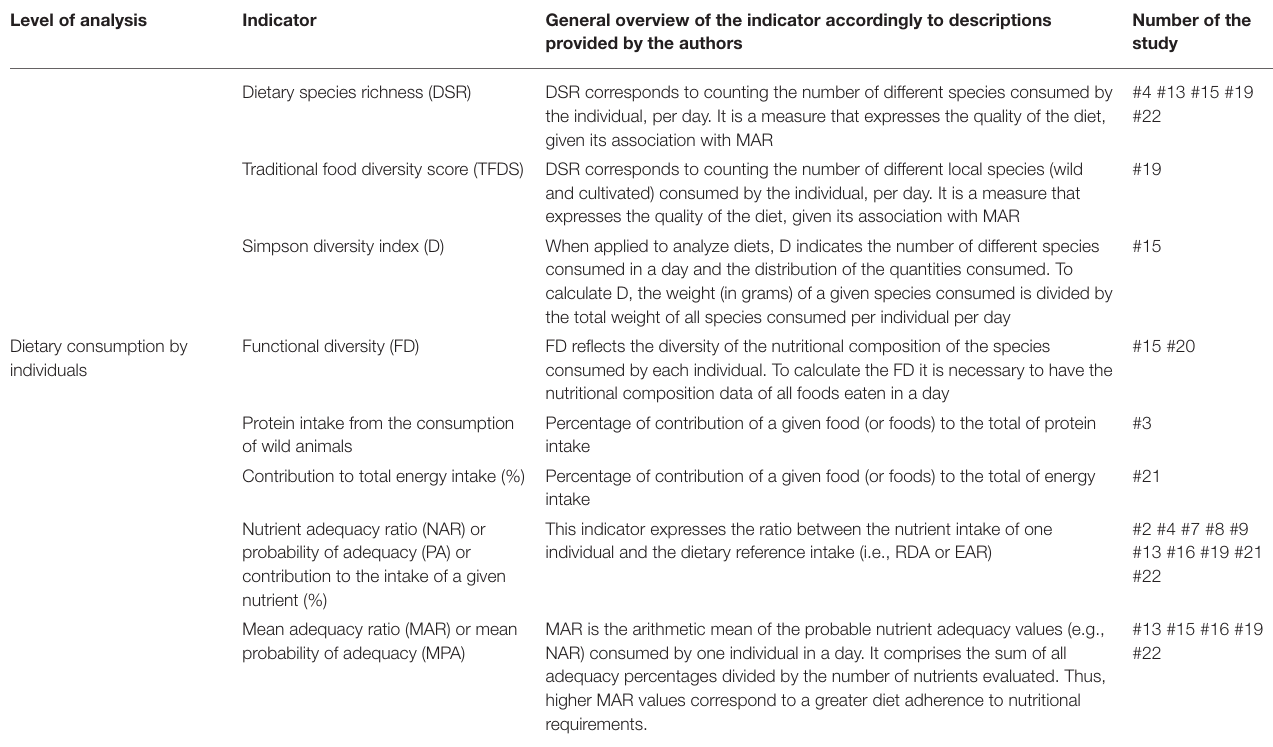
Indicator General overview of the indicator accordingly to descriptions provided by the authors Dietary species richness (DSR) DSR corresponds to counting the number of different species consumed by the individual, per day. It is a measure that expresses the quality of the diet, given its association with MAR